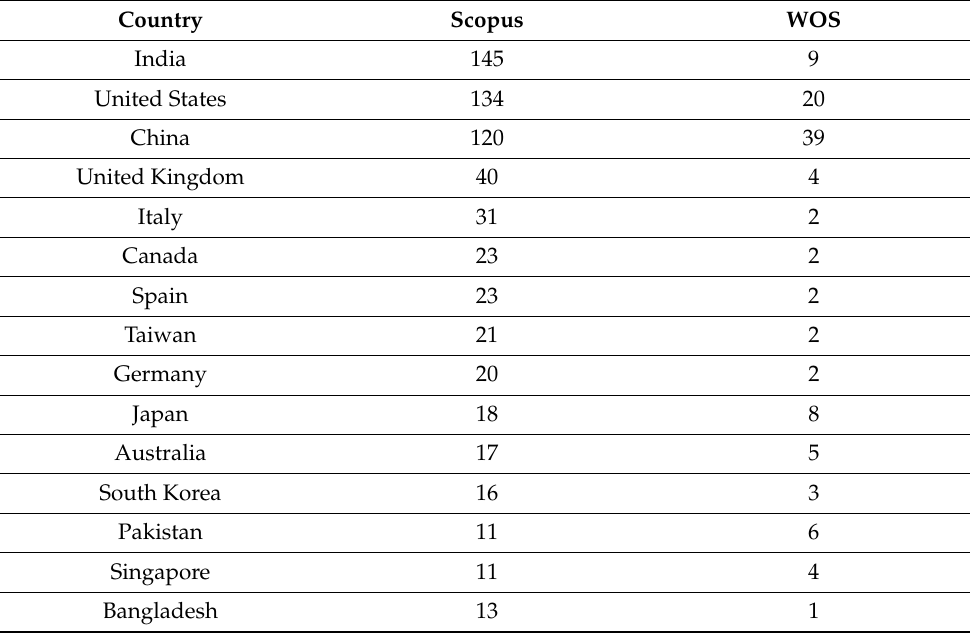
Figure 6. Geographic locations of research related to text-based emotion detection. Table 8. Fifteen major contributing countries in the field of text-based emotion detection using artificial intelligence.